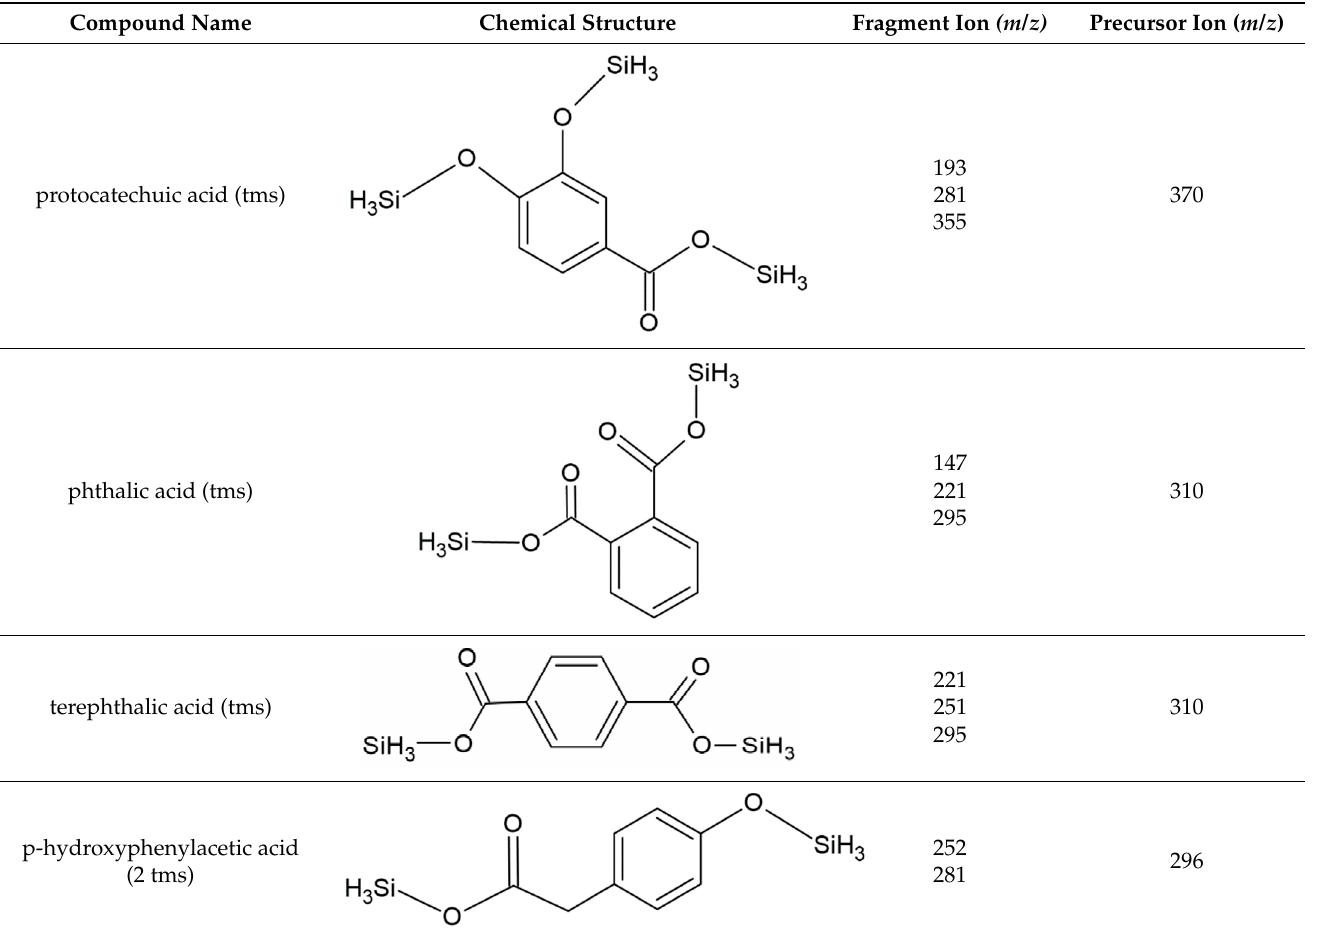
Table 2. Metabolites of degradation of PHE, B[a]A, and B[a]P obtained after N. pironii cultivation in the presence of